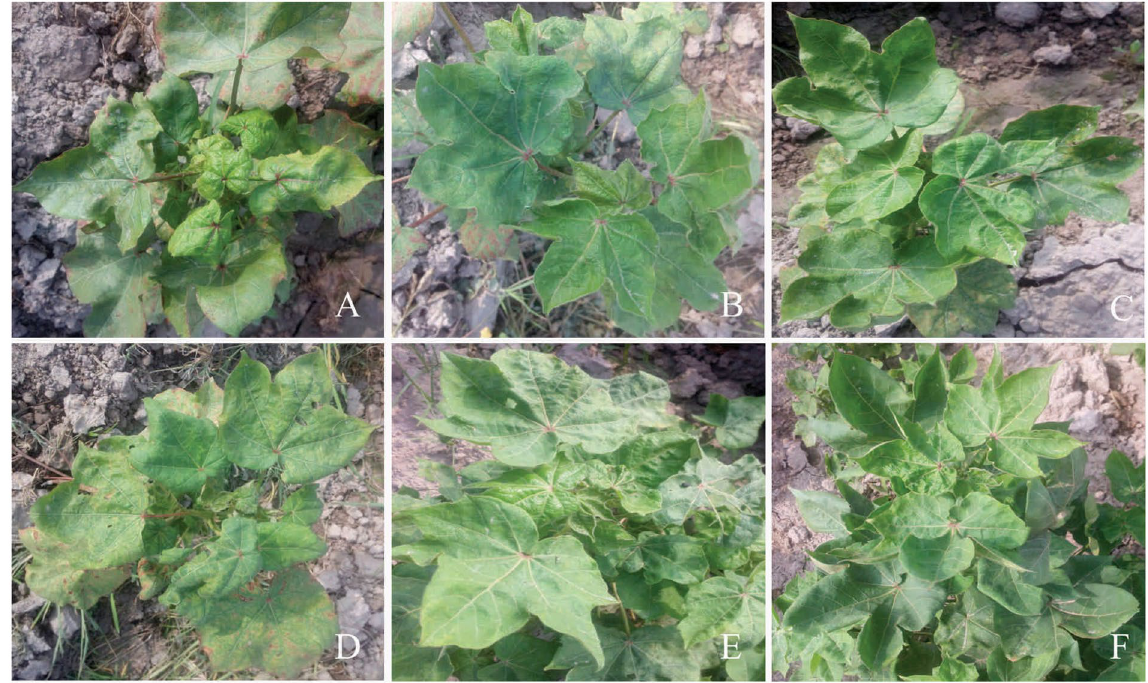
Figure 1. Cotton ( Gossypium hirsutum ) plants ( A–F ) from Vehari exhibiting typical symptoms of cotton leaf curl